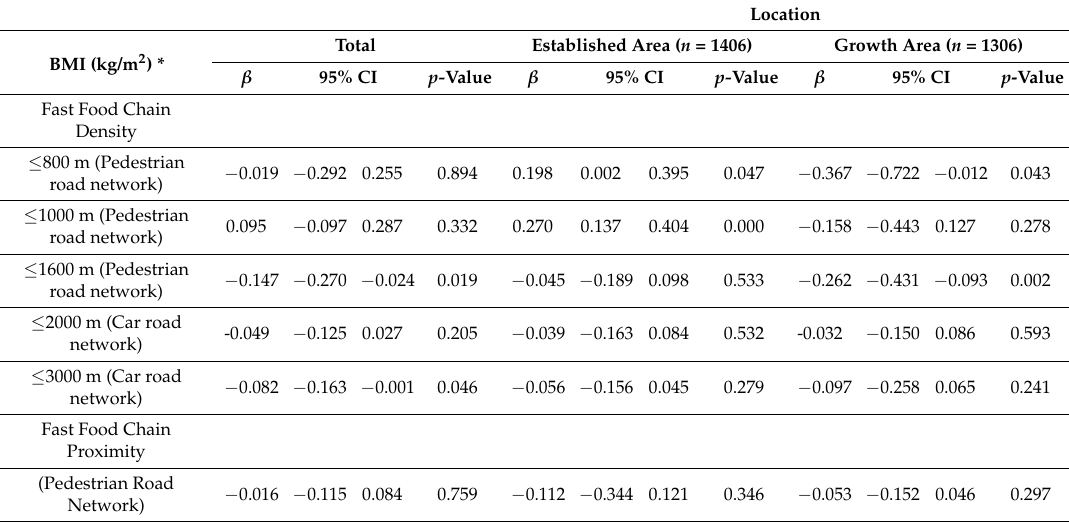
Table 3. Generalized estimating equations (GEE) models of associations between BMI and measures of fast food access for urban PHS respondents ( n = 2712) by